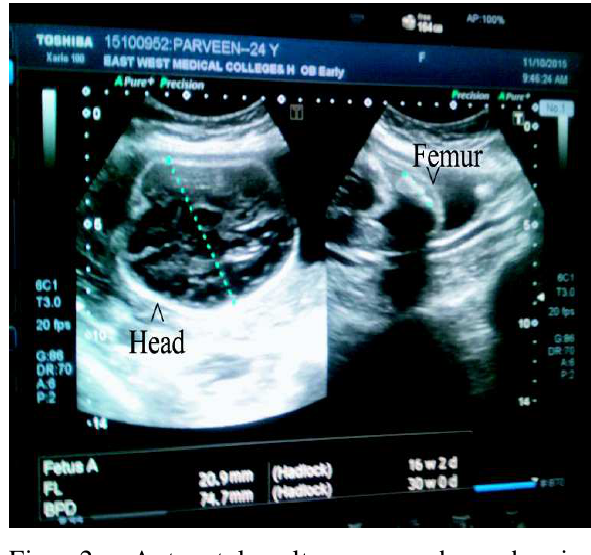
Fig 1. Antenatal ultrasongraphy showing narrow thoracic cage and mesocardia (altered cardiac axis)